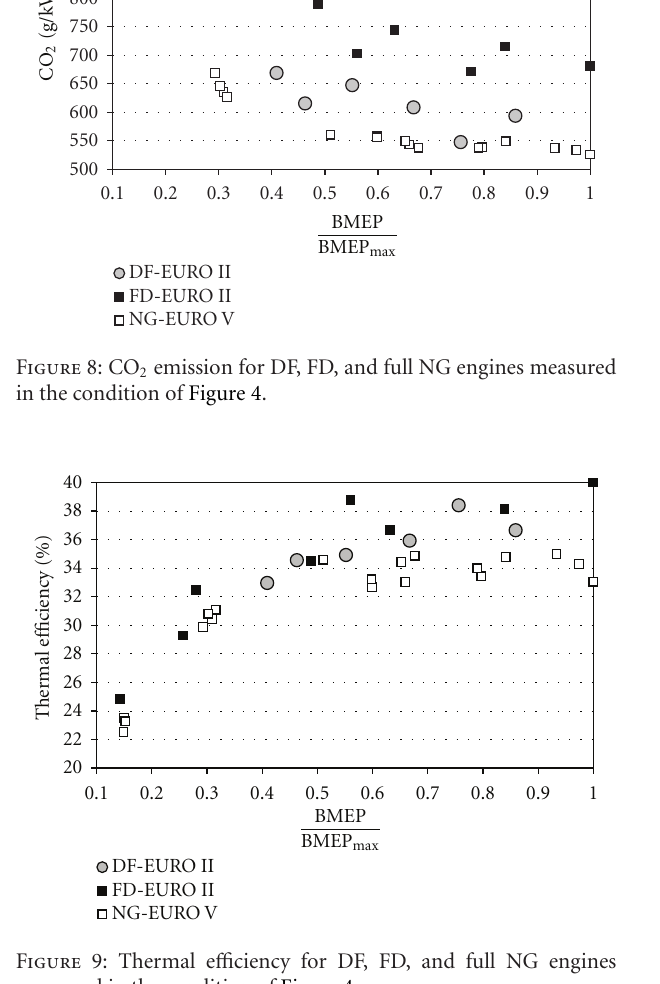
Table 5: Potential electric performance of a CHP plant with a DF engine considering the waste from 10,000 people (CC: combined cycle, EE: electric